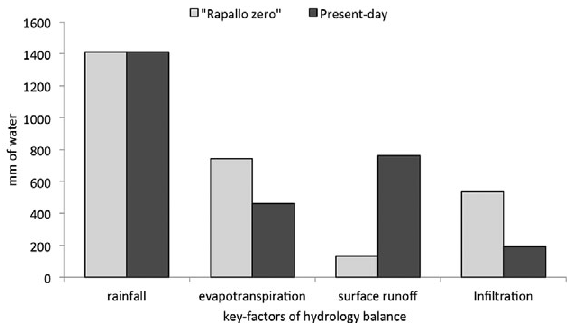
Fig. 14. Key factor of hydrology balance histogram at present-day and “Rapallo zero” land-use conditions of floodplain.